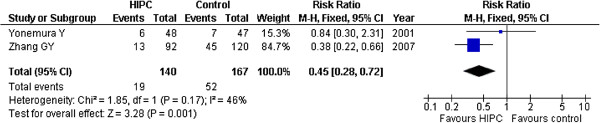
Risk Ratios for peritoneal dissemination.